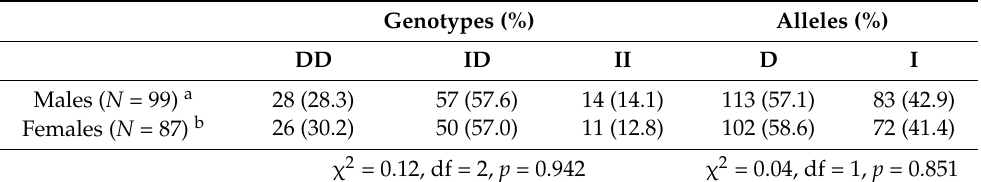
Table 2. The frequency of ACE genotypes and alleles among male and female